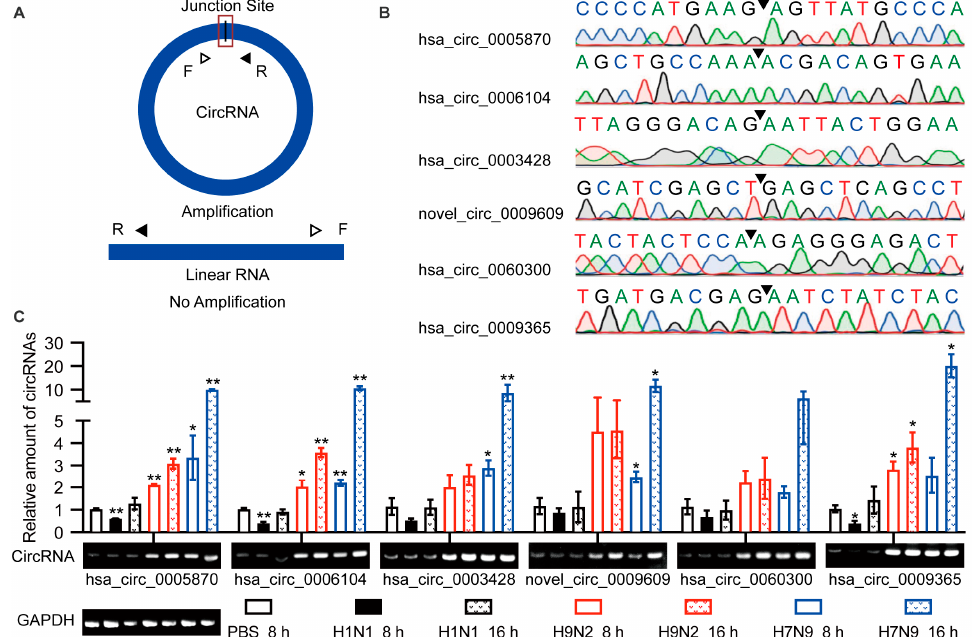
Figure 3. Verification of the circular properties of the selected circRNAs. ( A ) Schematic diagram of PCR primer. The product is expected to be amplified only from circRNAs, not from linear RNAs. ( B ) The total RNAs were treated with RNase R. The junction sites of circRNAs were identified by Sanger sequencing and are represented by arrows. ( C ) Validation of the differential expression of circRNAs during IAV infection. Six circRNAs were selected, quantified by RT-qPCR, and primers were designed to amplify the junction region. Data were normalized to GAPDH , and the mean ± SD ( n = 3) is shown. * p < 0.05 and ** p < 0.01.